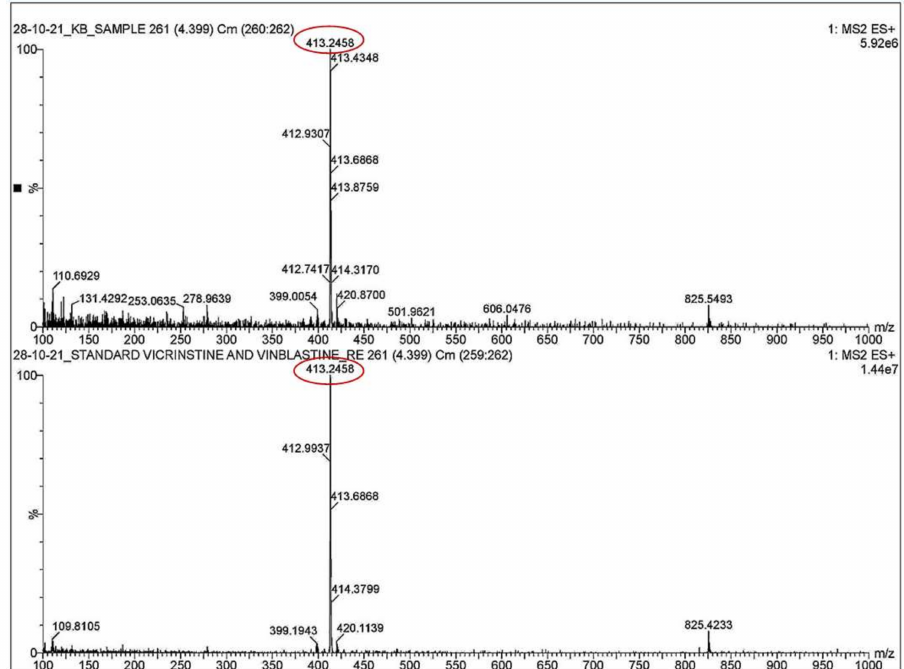
Figure 6. Mass spectrometry for vincristine in sample and vincristine standard showing m/z [M+2H] 2+ =